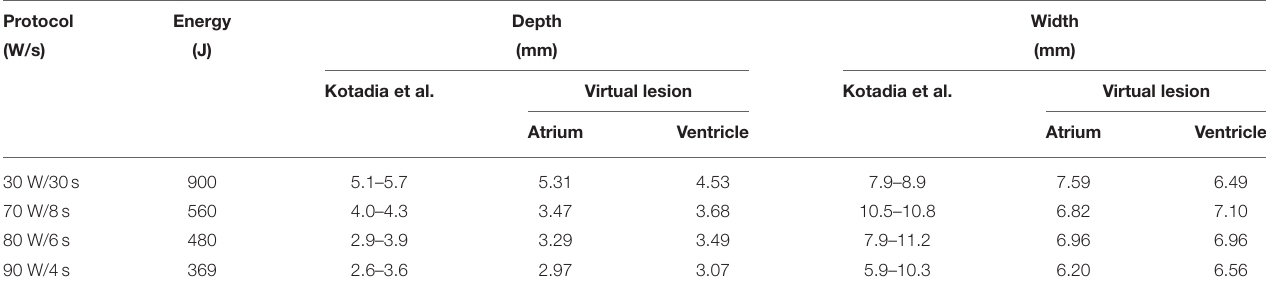
TABLE 2 | Comparison between HPSD and standard ablation protocols derived from several in-silico , ex-vivo, and in-vivo studies compiled by Kotadia et al. (24) against the lesions simulated by our model in atrium and ventricle.